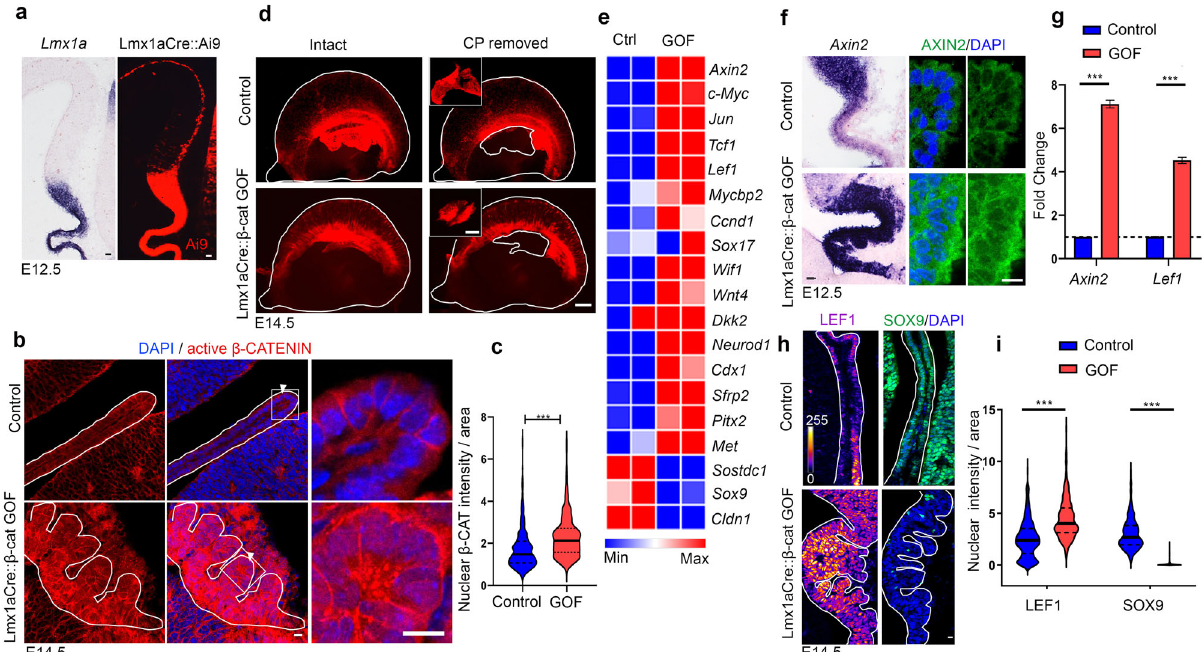
Fig. 2 Stabilization of β -CATENIN leads to activation of canonical Wnt signaling. ( a ) At E12.5, in situ hybridization for Lmx1a shows endogenous expression; the Ai9 reporter labels the Lmx1a -expressing lineage, including the hem, ChPe, and hem-derived Cajal-Retzius cells. ( b , c ) At E14.5, nuclear localization of active (non-phosphorylated) β -CATENIN is increased in the Lmx1aCre:: β -cat GOF ChPe compared with controls (arrowheads) as seen by ( b ) immunohistochemistry and ( c ) a violin plot representing quantitation of n = 294 nuclei (control) and n = 301 (GOF); N = 3 brains (biologically independent replicates) for each genotype examined over 2 separate experiments. Boxed regions ( b ) are shown at high magni fi cation in the adjacent panels. ( d ) Microdissection of E14.5 Ai9-labeled telencephalic hemispheres to isolate ChP (inset) for RNA extraction. ( a , d ) Representative images of sections taken from N = 3 brains (biologically independent replicates) examined over 2 independent experiments. ( e ) Heatmap (showing normalized reads) of Wnt signaling target genes from RNA-seq data from control and Lmx1aCre:: β -Catenin GOF ChP ( N = 2 biologically independent replicates). Color key: red (high expression) and blue (low expression) ( f – i ) In situ hybridization ( Axin2 ), qPCR Axin2 and Lef1 , and immunohistochemistry (AXIN2, LEF1, and SOX9) reveal upregulation of AXIN2 and LEF1 and downregulation of SOX9 in the Lmx1aCre:: β -cat GOF ChPe compared with controls. ( f , h ) Representative images of sections taken from N = 3 brains (biologically independent replicates) examined over 2 independent experiments. Bar graphs ( g ) represent mean ± SEM, N = 3 brains (biologically independent replicates) for each genotype examined over 2 independent experiments. ( i ) Violin plots quantifying the nuclear intensity of LEF1 and SOX9, for LEF1: n = 505 nuclei for control and 500 nuclei for Lmx1aCre:: β -cat GOF ChPe, N = 5 brains (biologically independent replicates) for each genotype examined over 3 independent experiments; color key: dark blue (grey value = 0) and white (grey value = 255). For SOX9, n = 457 nuclei for control and 444 nuclei for Lmx1aCre:: β -cat GOF ChPe; N = 4 brains (biologically independent replicates) examined over 2 independent experiments. For violin plots ( c, i ) solid black line represents median and dotted lines represent quartiles). Statistical tests: Two-tailed unpaired Student ’ s t test with unequal variance ( c, g ), p < 0.0001 ( c ), p = 0.0005 ( g , Lef1) and p = 0.0003 ( g , Axin2) ; two-tailed unpaired multiple Student ’ s t test with unequal variance ( i ), p < 0.000001 ( i , LEF1 and SOX9). * p < 0.05, ** p < 0.01, *** p < 0.001, ns if p value > 0.05. Scale bars: 10 μ m (all panels in a , b , f and h ); 100 μ m (all panels in d ). Source data are provided as a Source Data fi